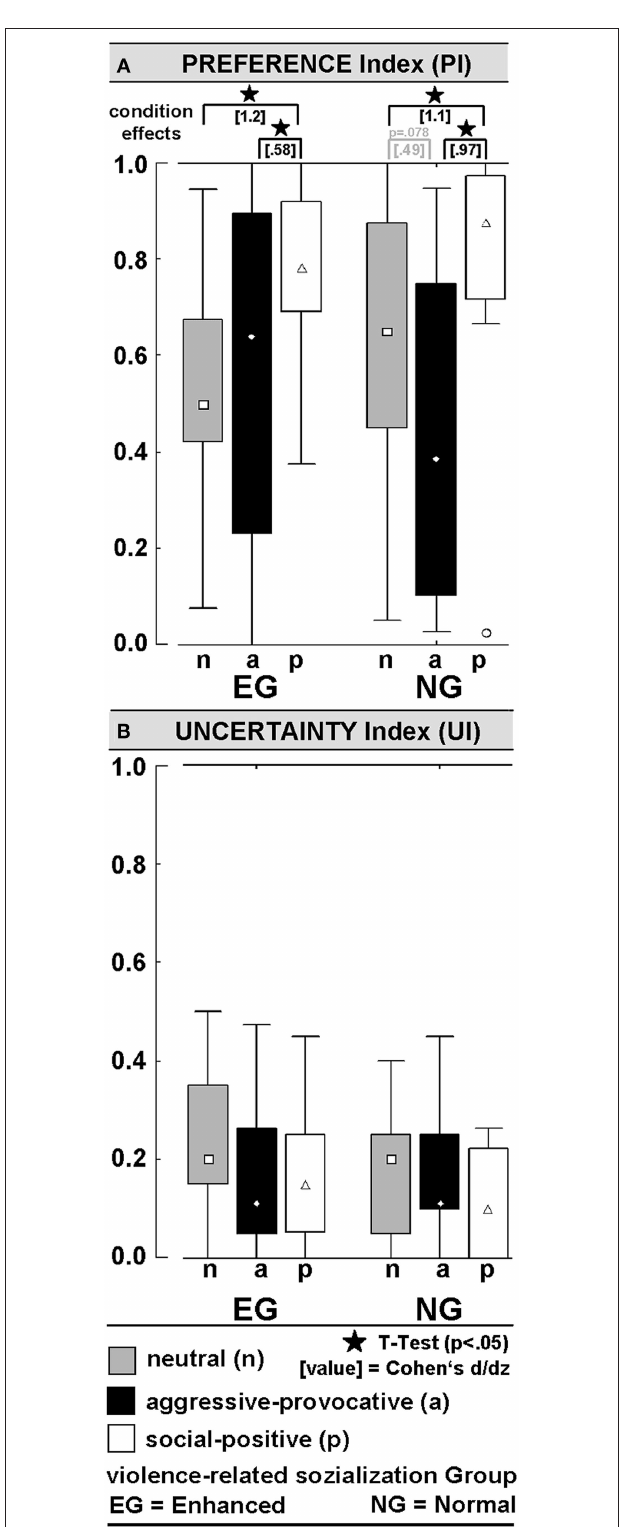
FIGURE 4 | Behavioral data during functional MRI (fMRI): (A) Preference-Index (PI) indicates the level of pro-active engagement in the stimulus categories ( = in no situation approach behavior was chosen; 1 = in all situations approach